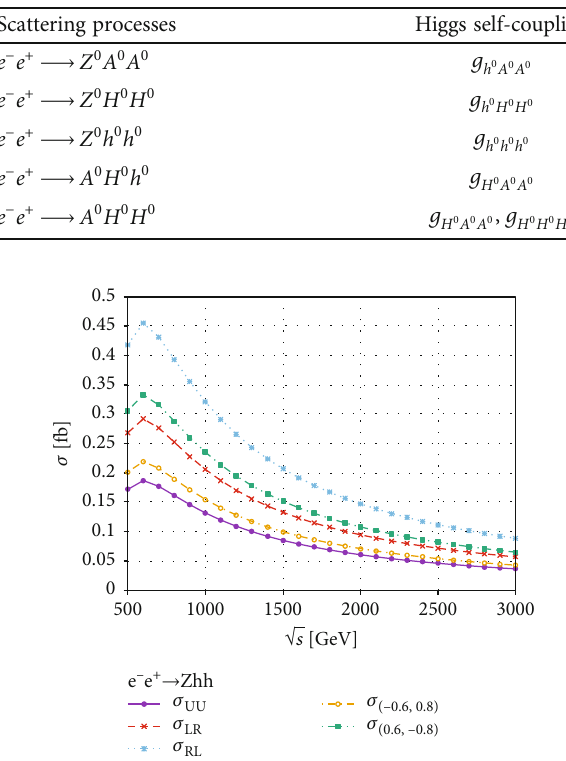
Figure 4: Total cross-section σ as a function of collider center of ffiffi p = 150 GeV or m = mass energy (GeV) at Higgs masses m s H H 175 GeV , tan β = 10 , and s = 1 are shown. βα Table 3: The cross-section in fb with unpolarized and fully polarized incoming e − e + beams, where masses of extra Higgs states are fi xed at m ϕ = 150GeV at tan β = 5